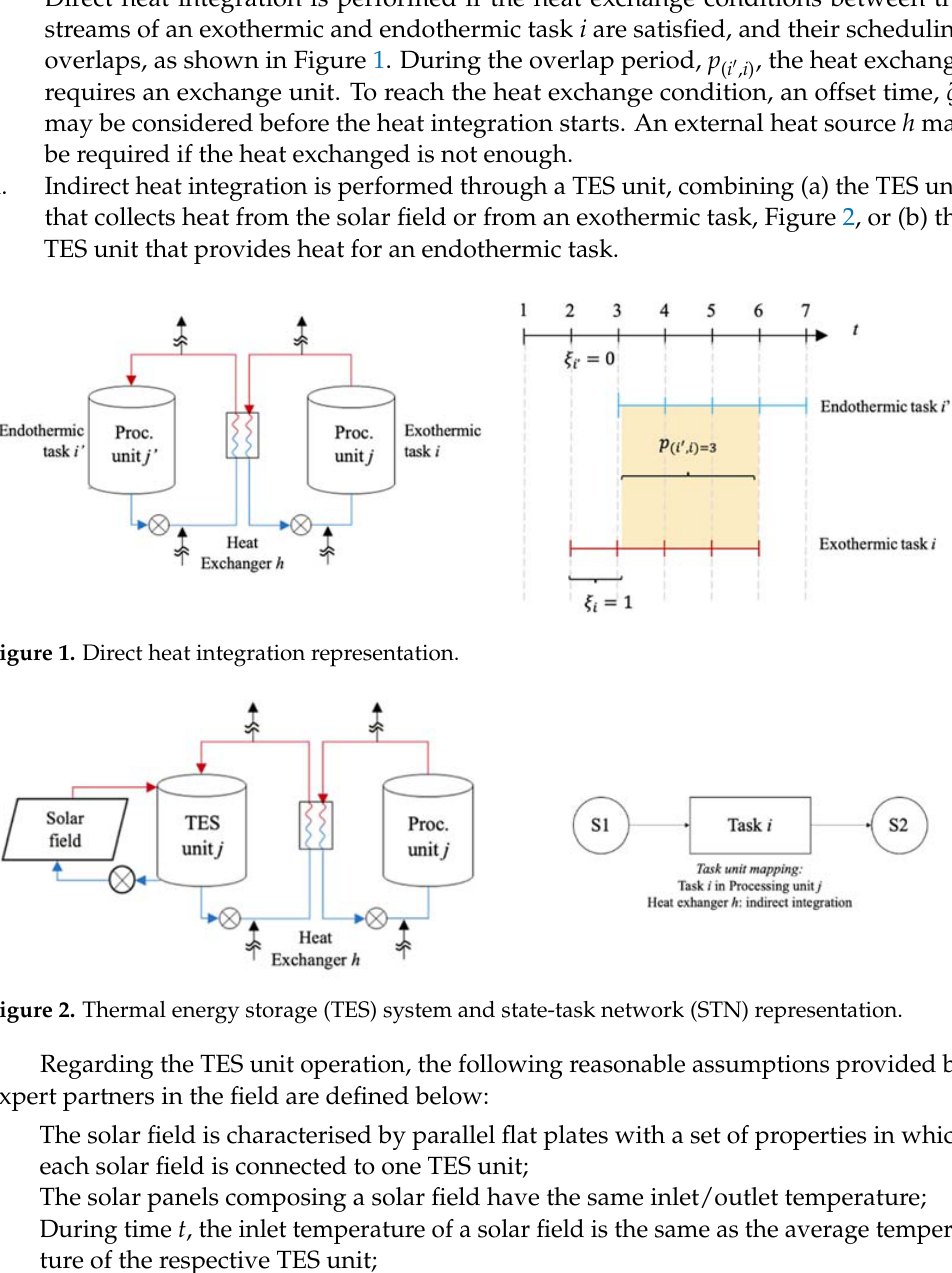
Figure 2. Thermal energy storage (TES) system and state-task network (STN) representation.